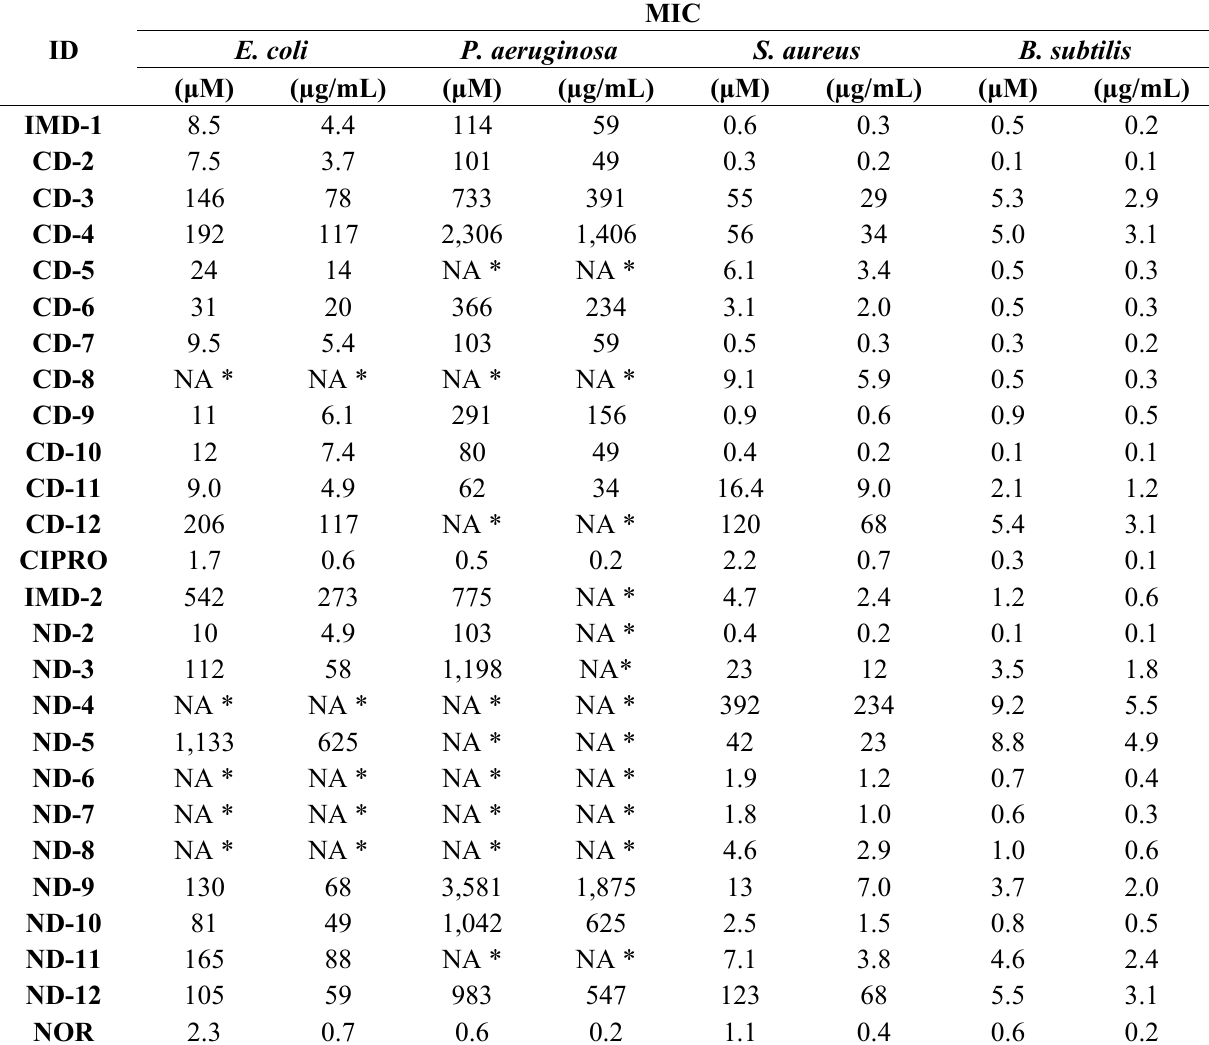
Table 1. The MIC values (μM) for compounds IMD-1 , IMD-2 , CD-2 to CD-12 and ND-2 to ND-12 and the reference compounds, ciprofloxacin (CIPRO) and norfloxacin